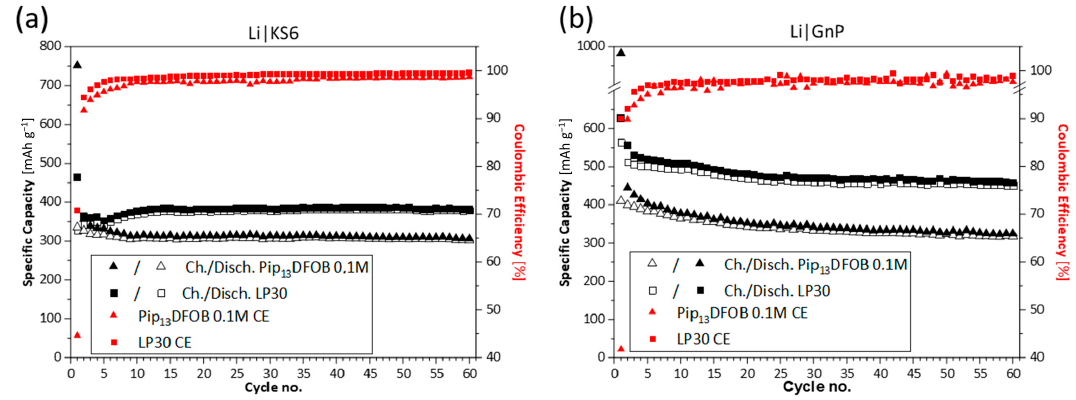
Figure 6. Galvanostatic cycling trends at 0.1C in Li|C, where C = KS6 ( a ) and C = GnP ( b ).